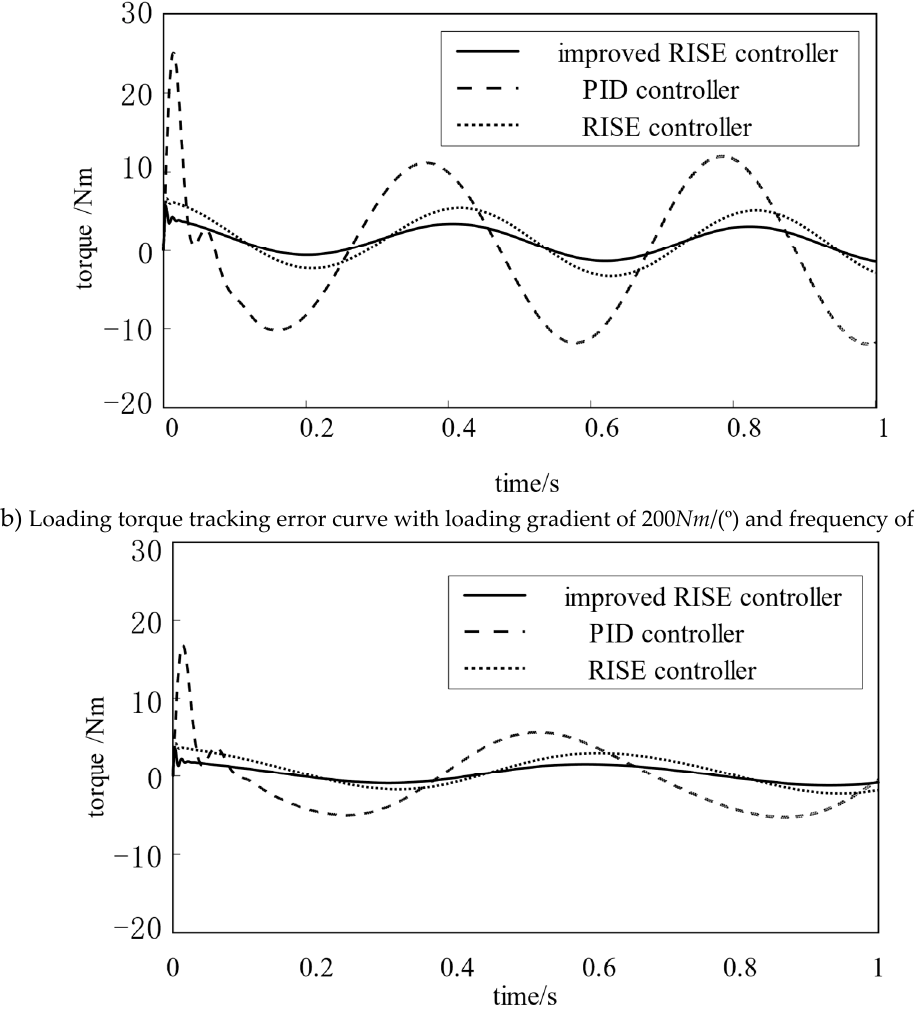
Figure 9. Tracking error of command torque.